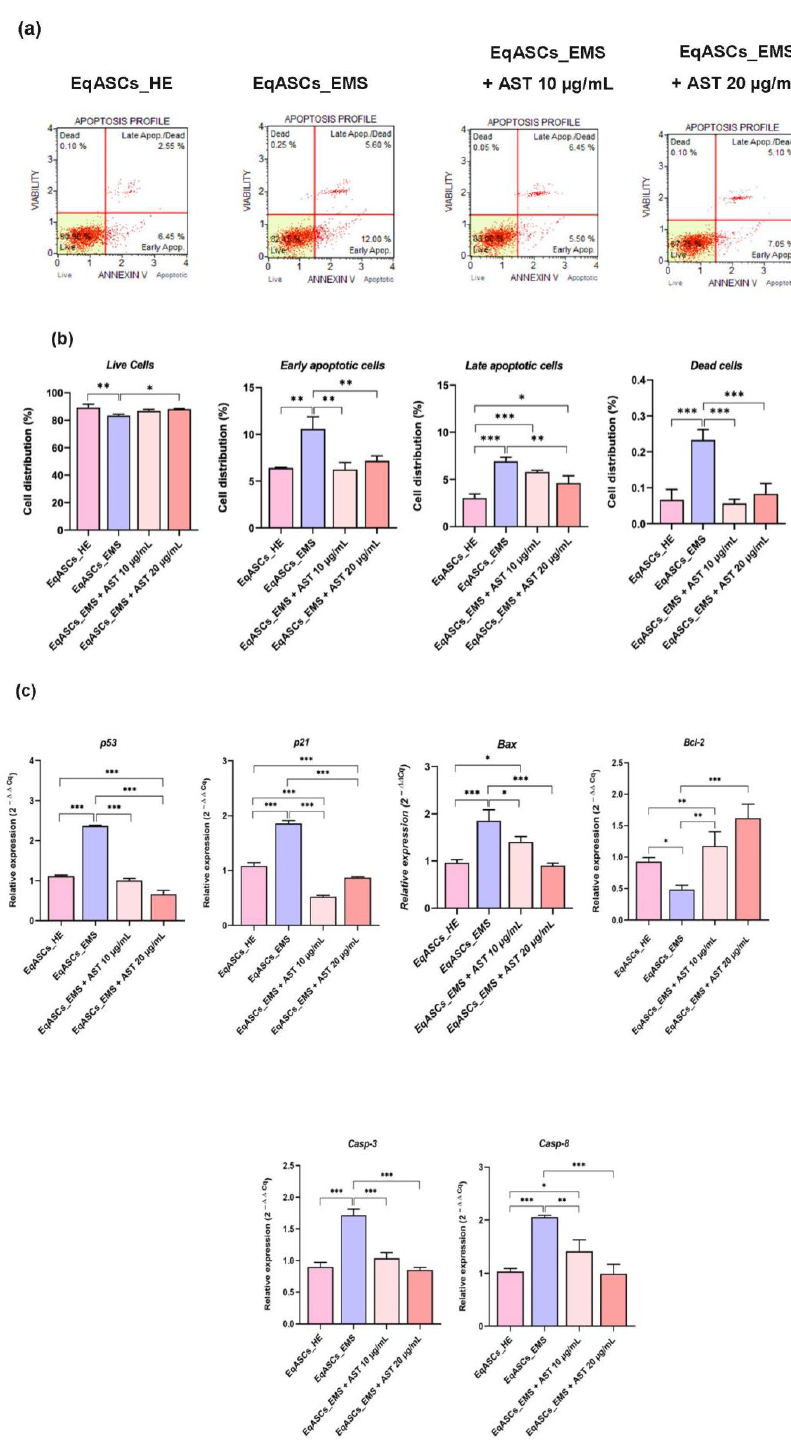
Figure 2. Antiapoptotic effect of Astaxanthin on EMS ASC cells. ( a ) The Muse ® Annexin V & Dead Cell assay was used to assess live cells, early and late apoptotic cells, and dead cells. ( b ) According to the Muse ® Annexin V & Dead Cell assay, histograms reflect the ratio of live, early apoptotic, late apoptotic, and dead cells. ( c ) Bar charts illustrating the relative expression of major apoptotic markers. A comparison of EMS, treatment groups and untreated healthy cells is shown by an asterisk (*). * p < 0.05, ** p < 0.01, *** p < 0.001.